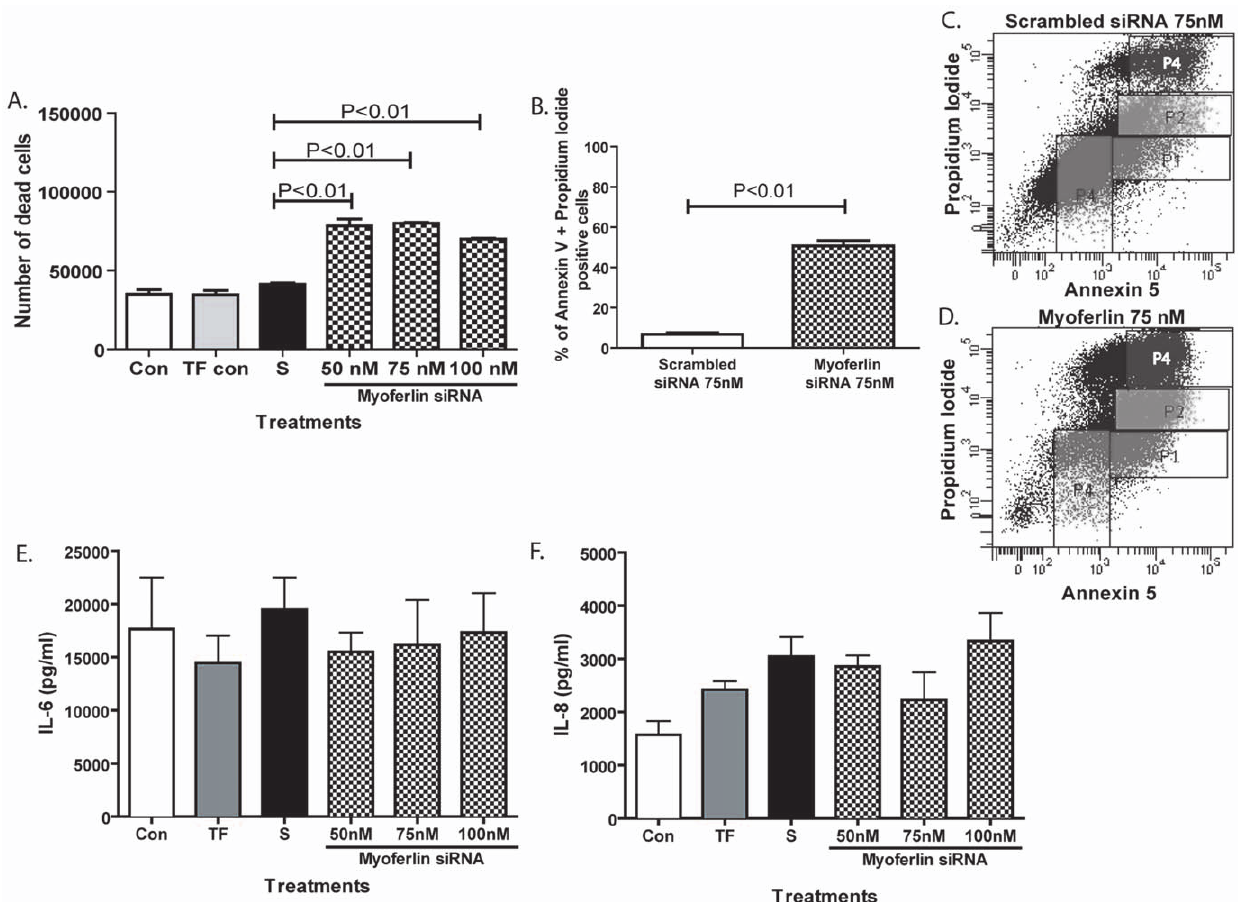
Figure 6. Myoferlin knockdown induces changes in cell detachment and apoptosis but not inflammation. 16HBE cells were treated with control media (con), transfection control (TF con), scrambled siRNA (S), or myoferlin siRNA at 50 nM, 75 nM and 100 nM for 72 h. Cell culture supernatants were removed and analyzed for (A) dead cells using trypan blue assay and (B) percentage of cells positive for annexin 5 and propidium iodide by FACs analysis, which are surrogate markers of apoptosis. Representative FACs plots of 16HBE cells treated with (C) scrambled siRNA control compared to (D) myoferlin siRNA at 75 nM concentration indicate elevated numbers of cells positive for propidium iodide and annexin 5 (gated in P4). Cell culture supernatants were also analyzed for inflammatory cytokines (E) interleukin (IL)-6 and (F) IL-8. Data are presented as mean 6 SEM of six independent experiments. A significant difference of p , 0.05 was considered significant.